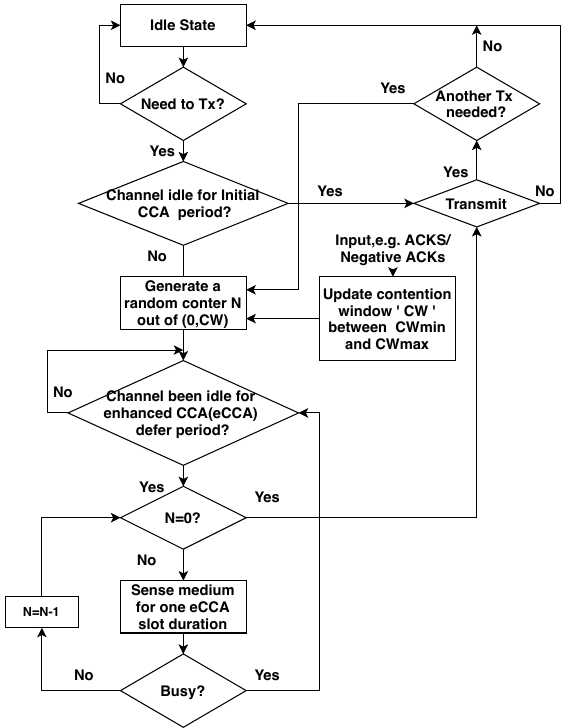
Figure 5. A flowchart of the LBT mechanism proposed by